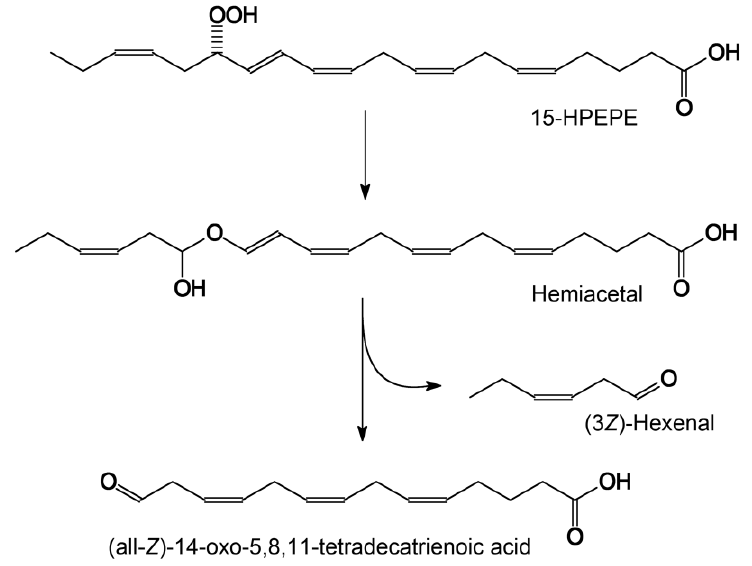
Figure 7. The mechanisms of 15( S )-HPEPE conversions by ShHPL to major product—(all- Z )-14-oxo-5,8,11-tetradecatrienoic acid.